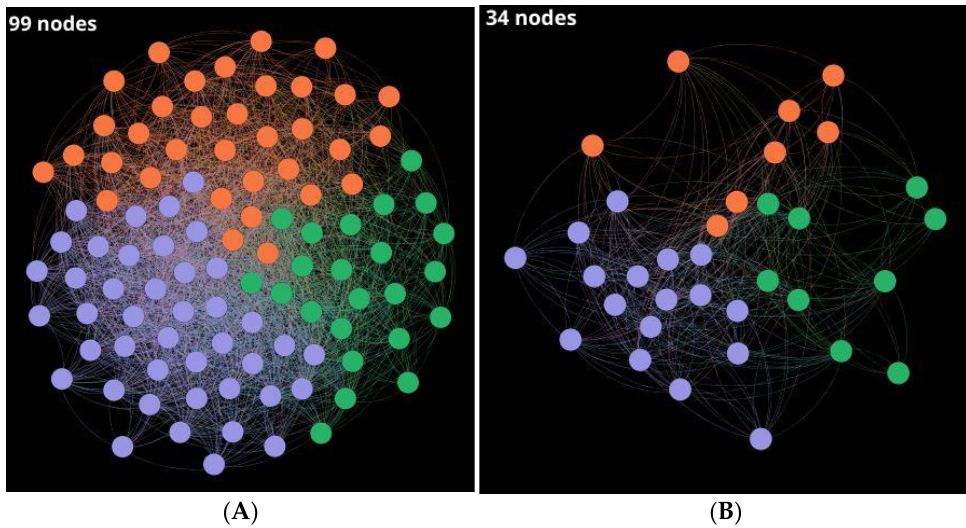
Figure 6. CSN of ( A ) 99 outliers with a density of 0.30 and ( B ) 34 remaining outliers resulting from 30% similarity extraction scaffold. Layout: Fruchterman – Reingold .